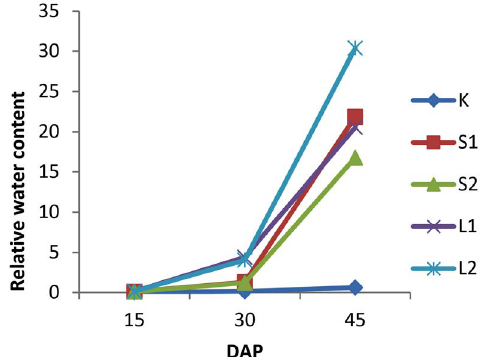
Fig. 4 . Induced compost effect on chlorophyll a of the leaves. K = control; S1 = Cellulolytic (10%); S2=Cellulolytic (20%); L1 = Ligninolytic (10%); L2 = Ligninolytic (20%).